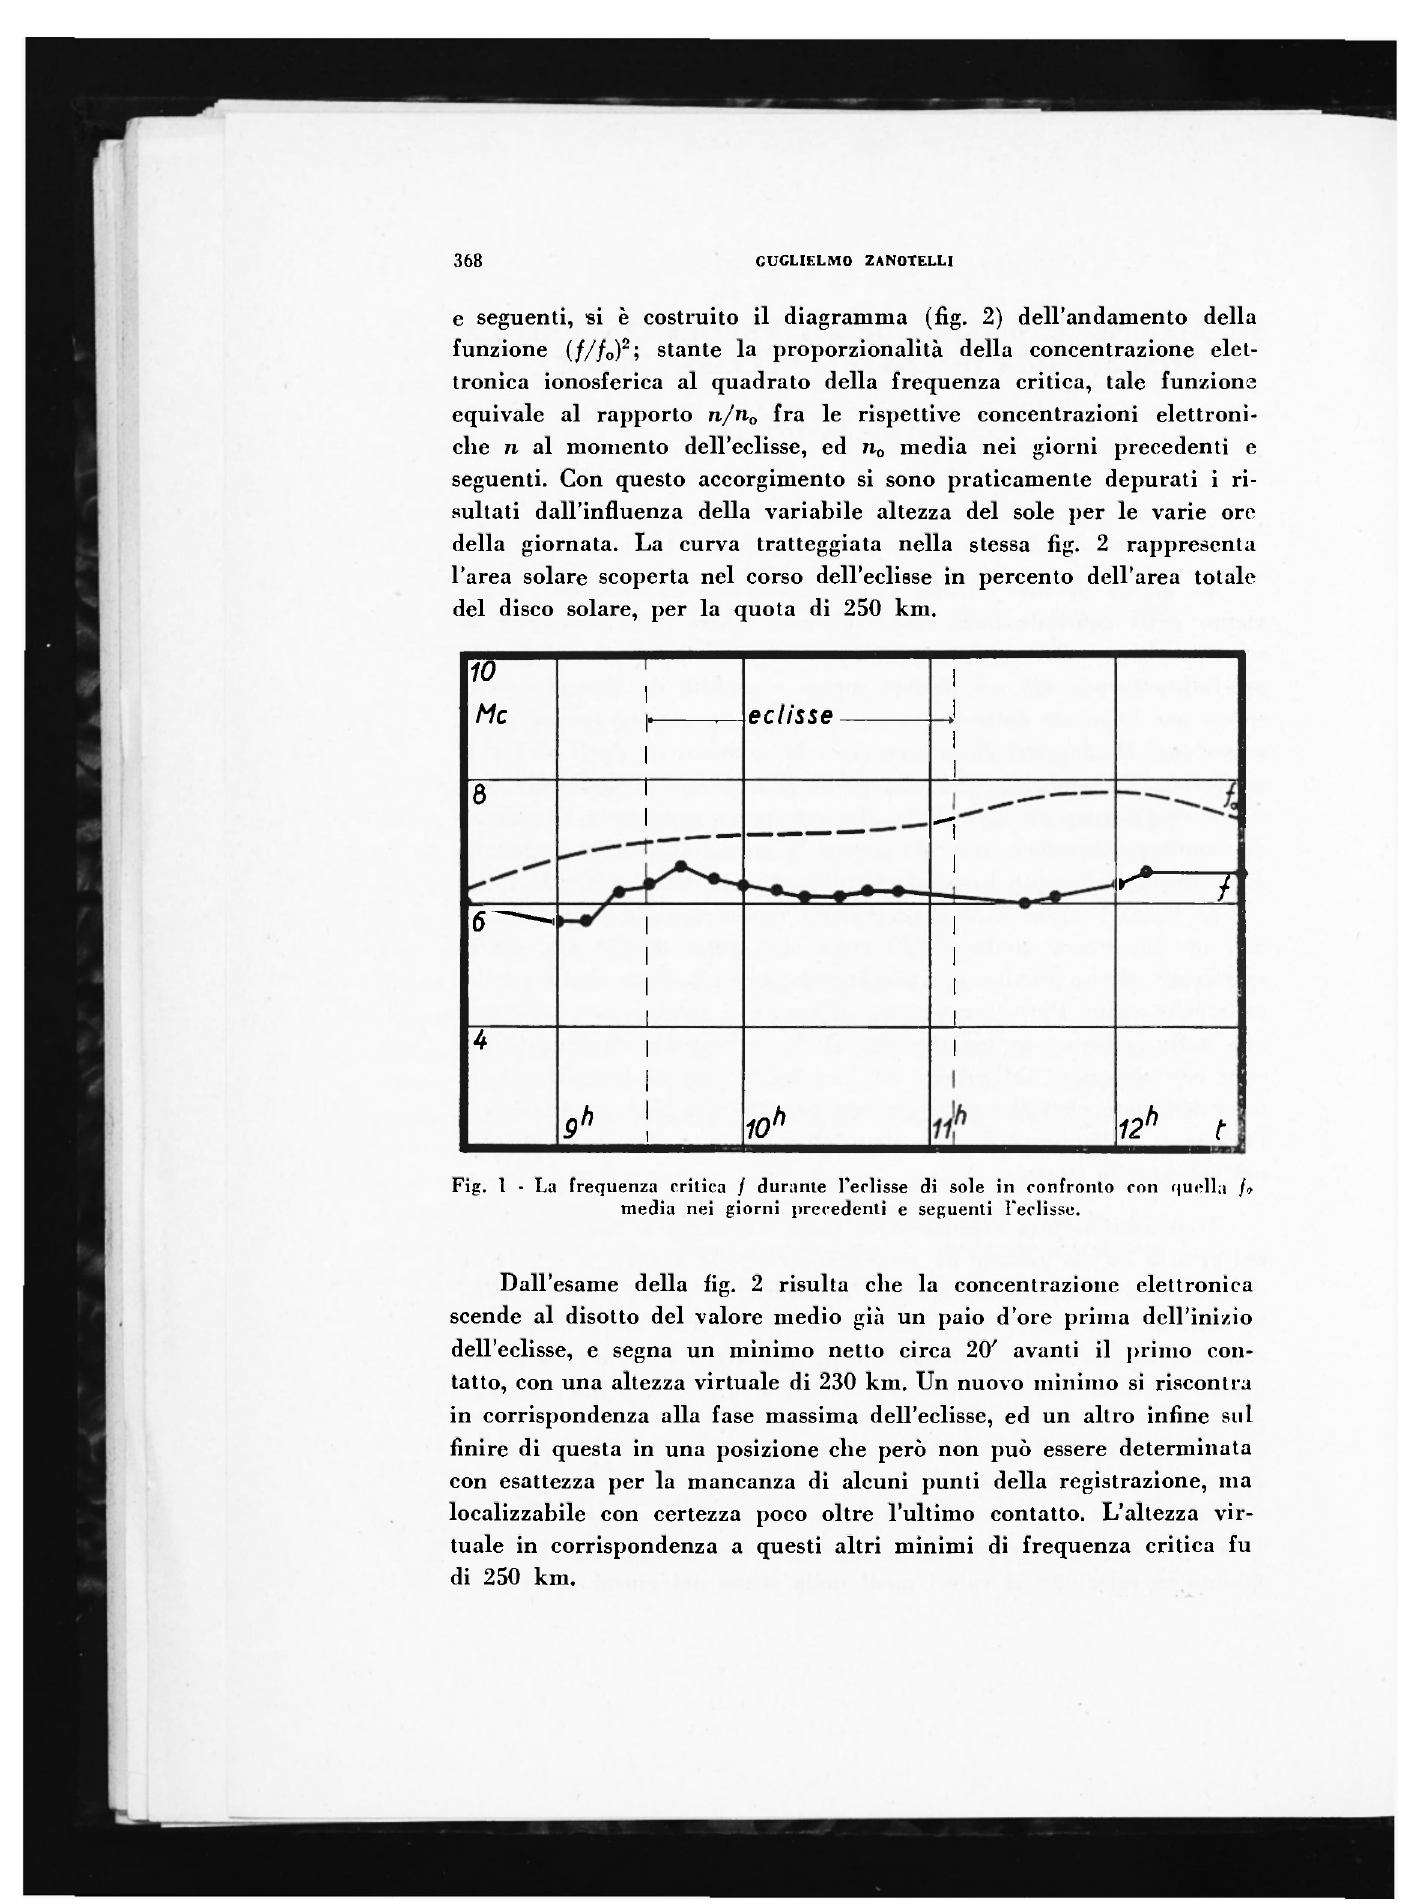
Fig. 1 - La frequenza critica / durante l'eclisse di sole in confronto con quella /» media nei giorni precedenti e seguenti